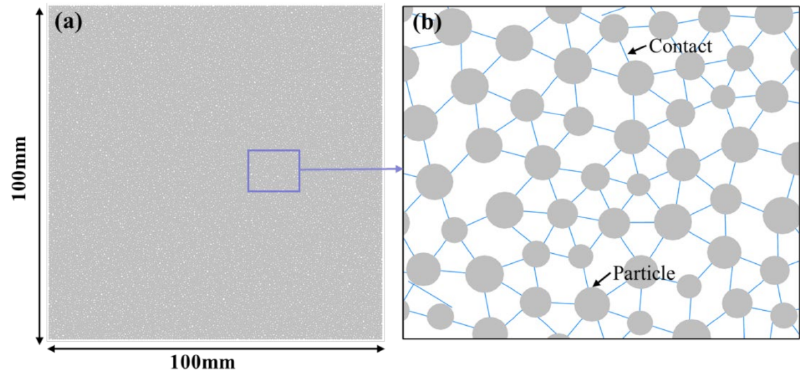
Figure 3. Numerical model of intact specimen, including ( a ) intact specimen and ( b ) the structure of particles and contacts in the model.